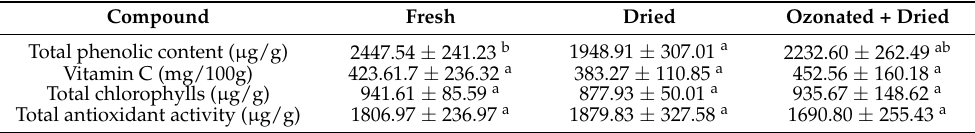
Table 2. Bioactive compounds and total antioxidant activity of fresh and freeze-dried melon peels, with and without ozone pre-treatment. The values are mean ± margin of confidence intervals at